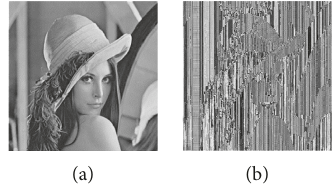
Figure 4: Effect of forward diffusion. (a) Lena image. (b) Forward diffused Lena image.